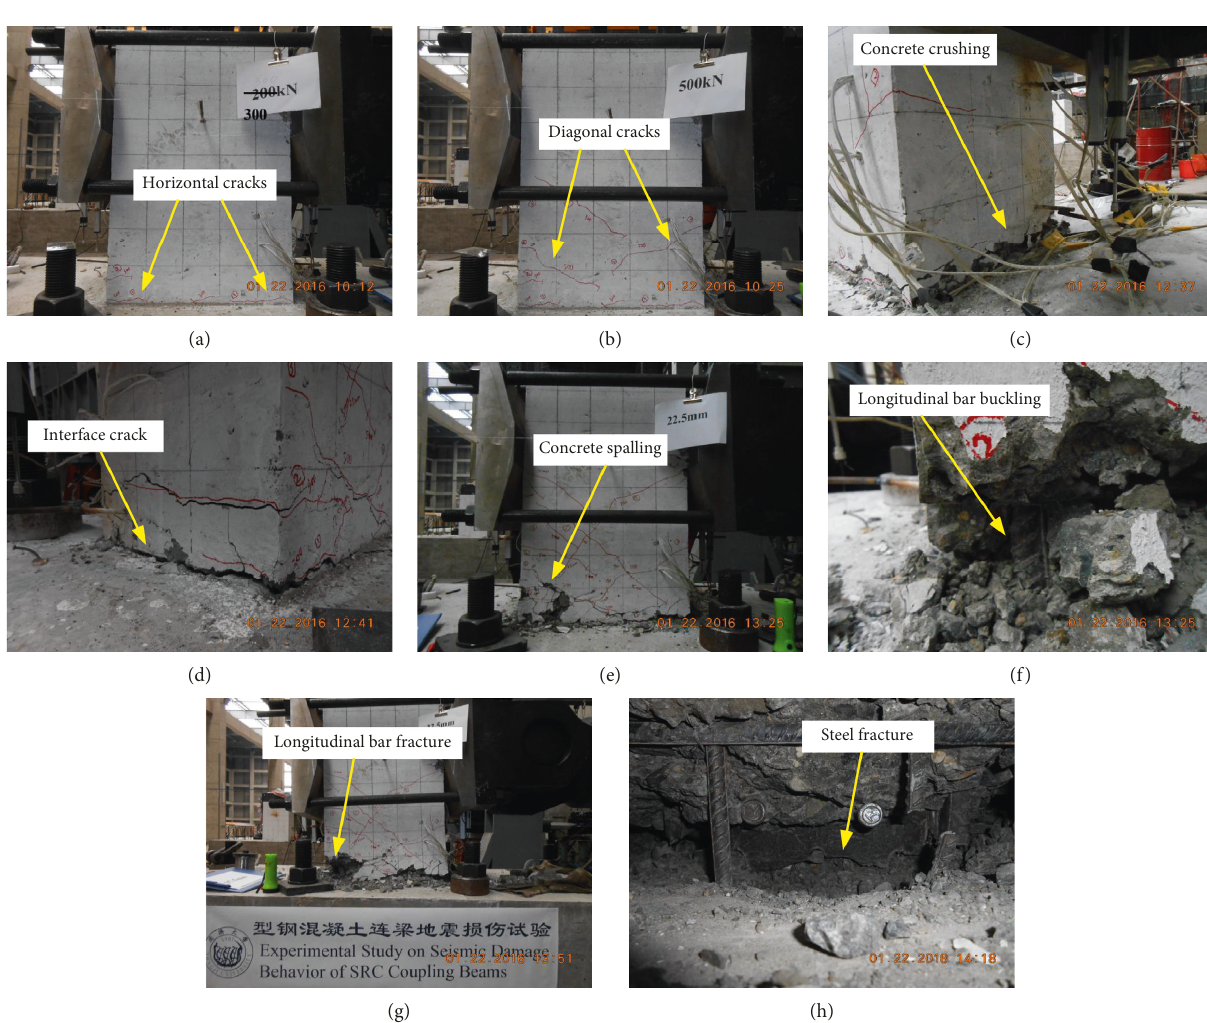
Figure 4: Typical damage states of specimen Beam1: (a) 300 kN (0.0012rad), (b) 500kN (0.003 rad), (c) 10mm (0.02 rad), (d) 12.5mm (0.025 rad), (e) 22.5mm (0.045 rad), (f) 27.5 mm (0.055 rad), (g) 32.5 mm (0.065 rad), and (h) 42.5mm (0.085 rad).